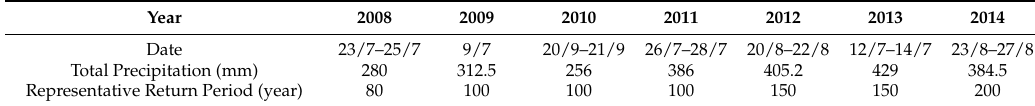
Table 1. Large rainfall events between 2008 and 2014 (data from Korea Meteorological